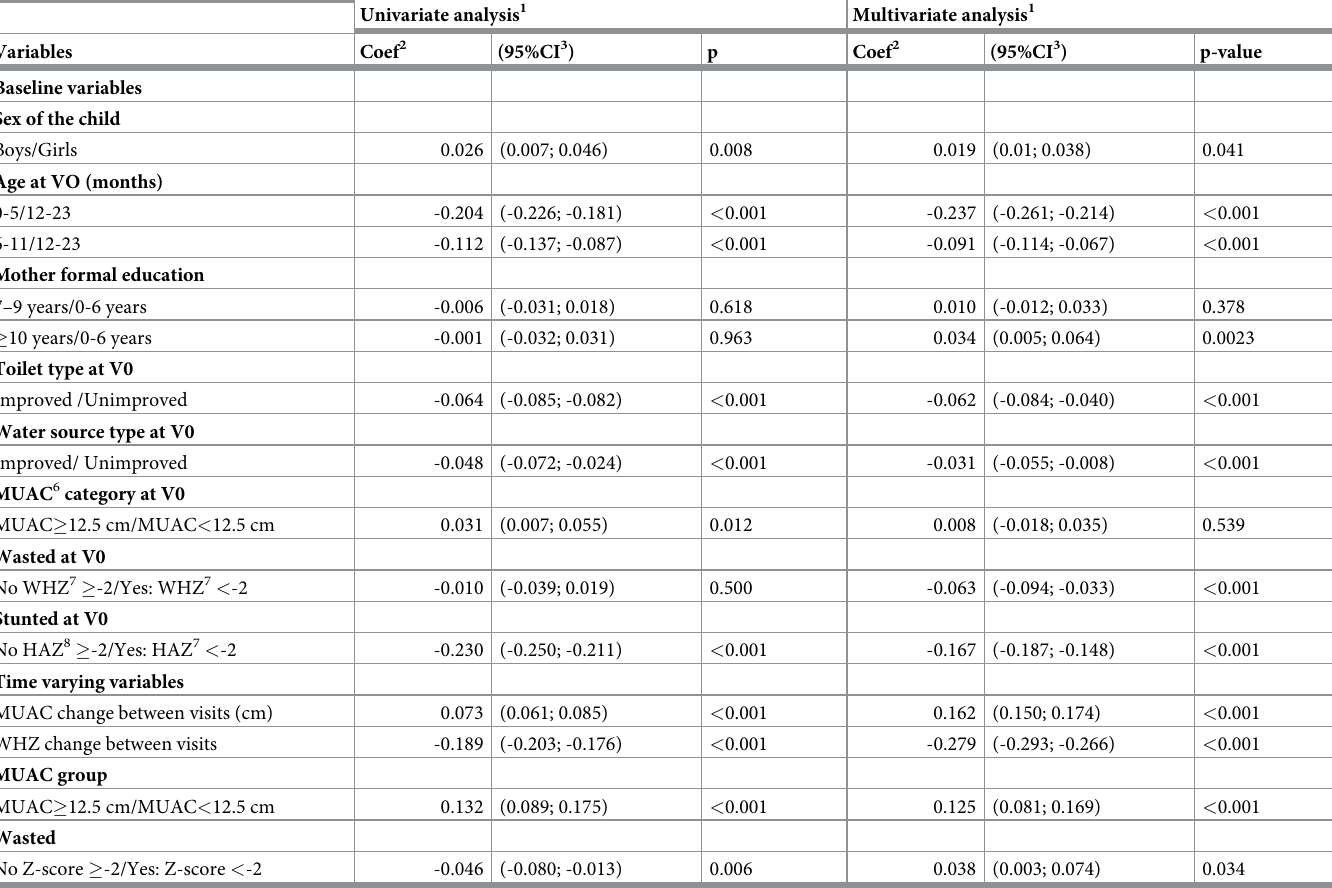
Table 3. Factors associated with height-for-age Z-score change overtime (N = 14226 and number of included children = 4629). Univariate analysis